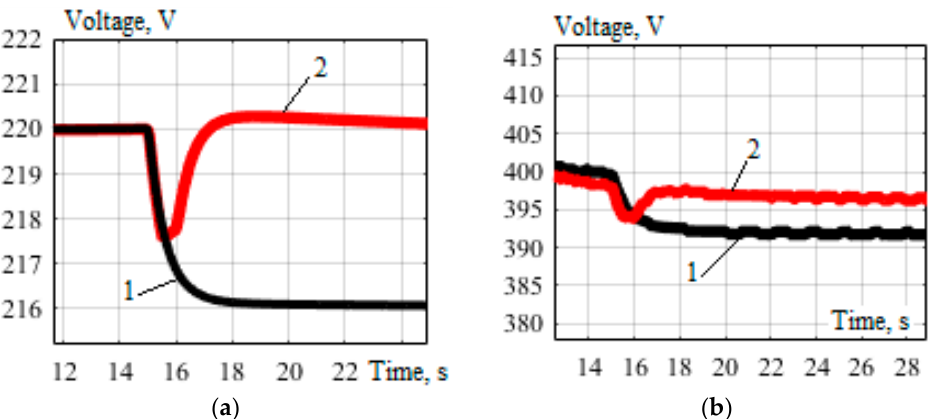
Figure 15. Time dependencies for voltages: ( a ) on the LV side of PRs (DC grid); ( b ) on the LV side of PRs (in the AC grid); 1—ES units at SPPs were permanently switched on; 2—ES units at SPPs were switched on when the voltage dropped .